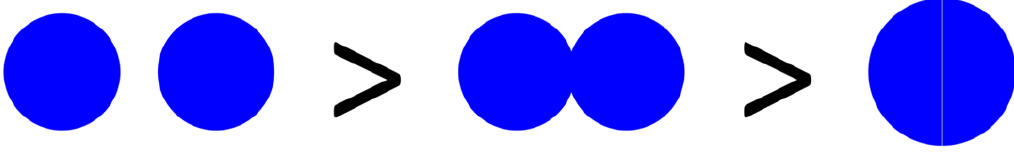
Figure 2. Shading of bacteria by bacteria. Shown is a progression starting with two “free” coccus-shaped bacteria (left) which is followed by a diplococcus displaying some degree of attachment (middle) that in turn is followed by a diplococcus displaying maximal attachment as well as minimized surface-to-volume ratio (right), i.e. , existing as a combined-volume sphere of 2 (cid:2869)/(cid:2871) -fold increased radius over an individual cell (see calculation, below). The left-hand lack of arrangement shows no shading whereas the right- hand arrangement shows an approximation of maximal shading for a combined spherical shape. The middle arrangement displays some intermediate degree of shading and therefore some intermediate overall target size between maximal and minimal (holding cell volumes constant). Note that the volume of a sphere, V , is equal to (cid:4672) (cid:2872) ) (cid:4673) (cid:2024)(cid:1870) (cid:2869)(cid:2871) . Twice its volume ( (cid:1848) 1 (cid:2870) (cid:2871) (cid:2872) (cid:2872) (cid:2876) therefore is (cid:4672) (cid:2876) (cid:4673) (cid:2024)(cid:1870) (cid:2869)(cid:2871) , which as a sphere is equal to (cid:4672) (cid:4673) (cid:2024)(cid:1870) (cid:2870)(cid:2871) . For (cid:4672) (cid:4673) (cid:2024)(cid:1870) (cid:2870)(cid:2871) (cid:3404) (cid:4672) (cid:4673) (cid:2024)(cid:1870) (cid:2869)(cid:2871) , (cid:2871) (cid:2871) (cid:2871) (cid:2871)